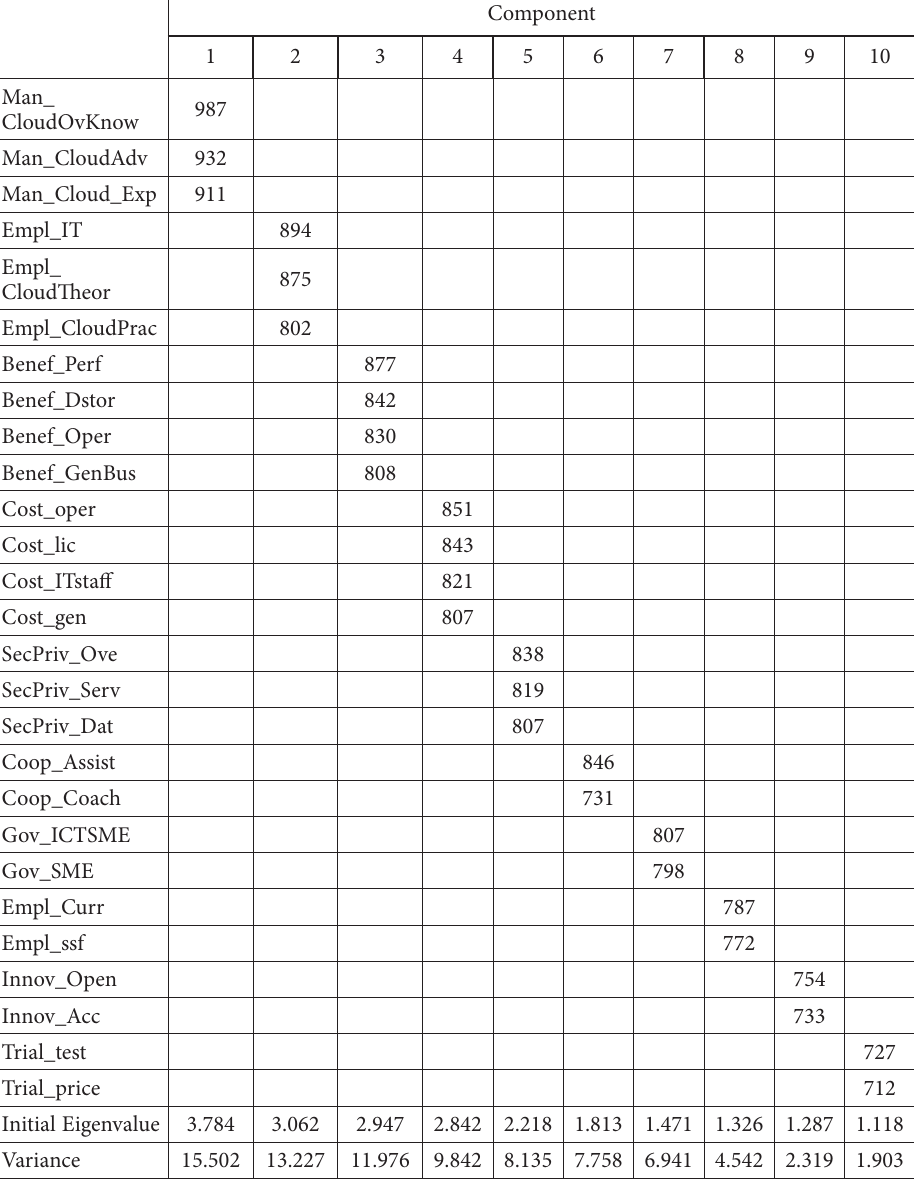
Table 11. Factor analysis